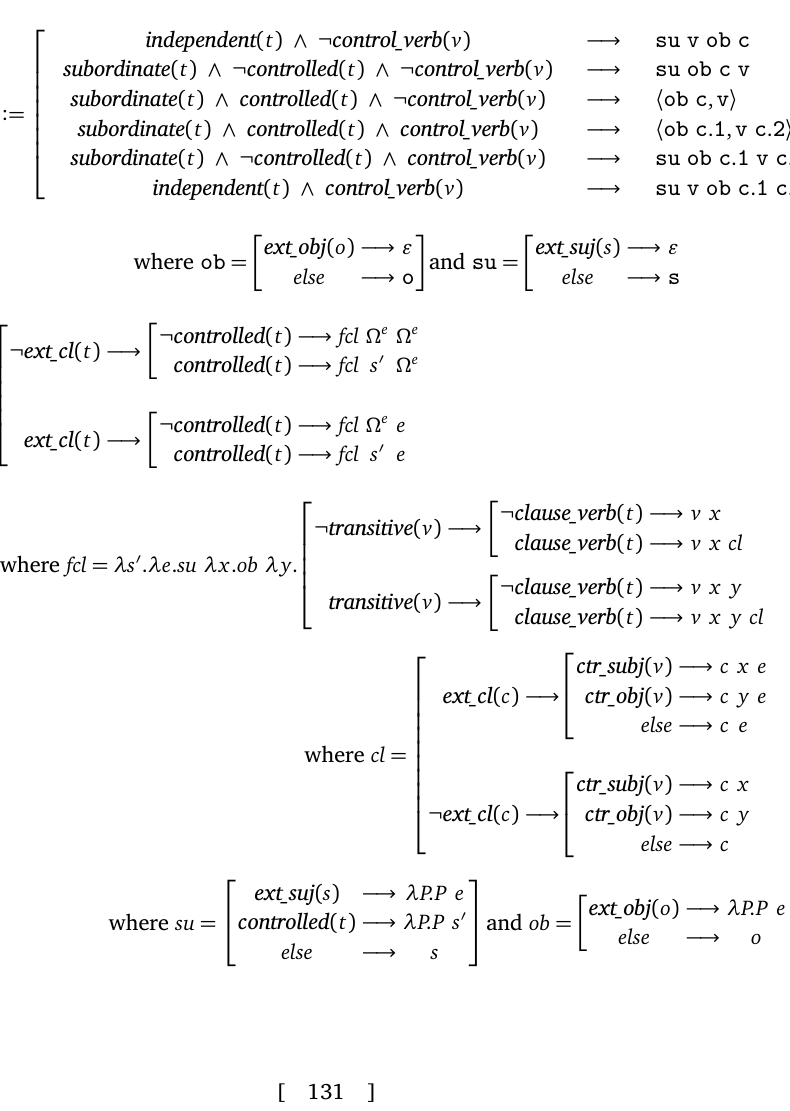
Figure 17: First part of the full synchronous grammar, with logical constraints and